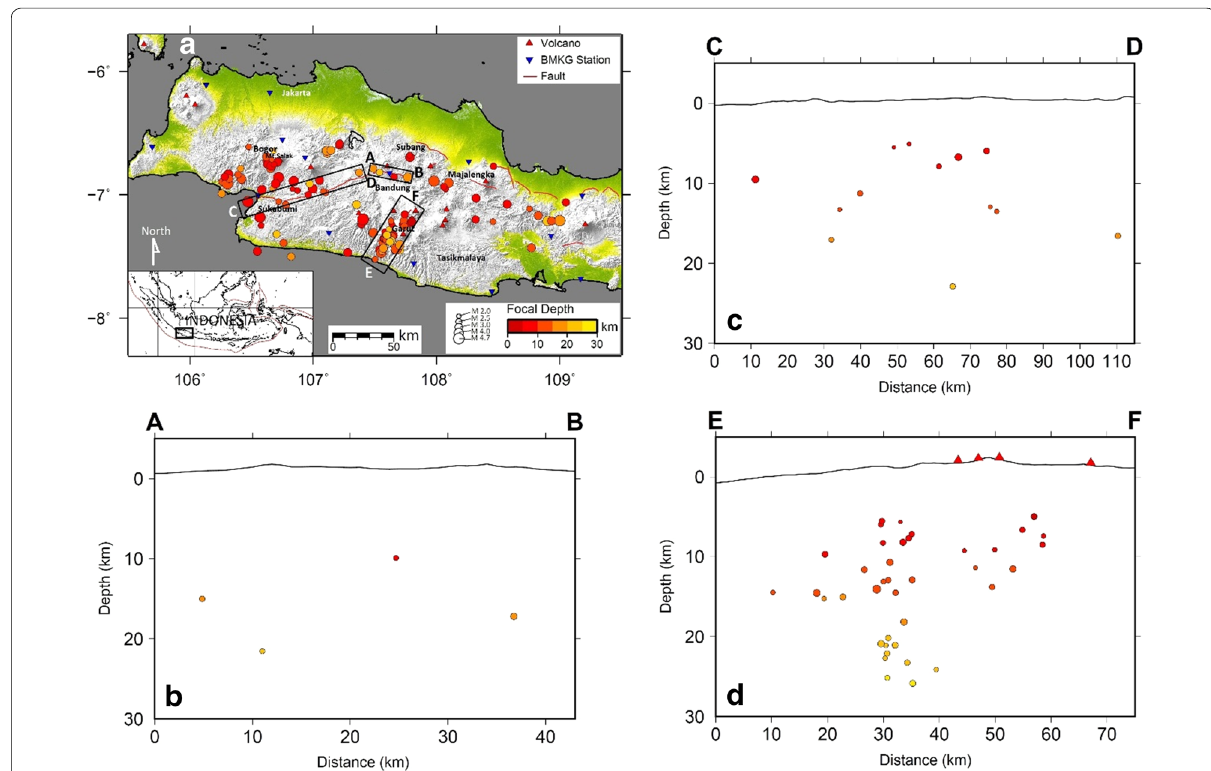
Fig. 4 a Map of relocated earthquakes, and vertical cross-sections along, b the Lembang fault, c the Cimandiri fault, and d the Garut